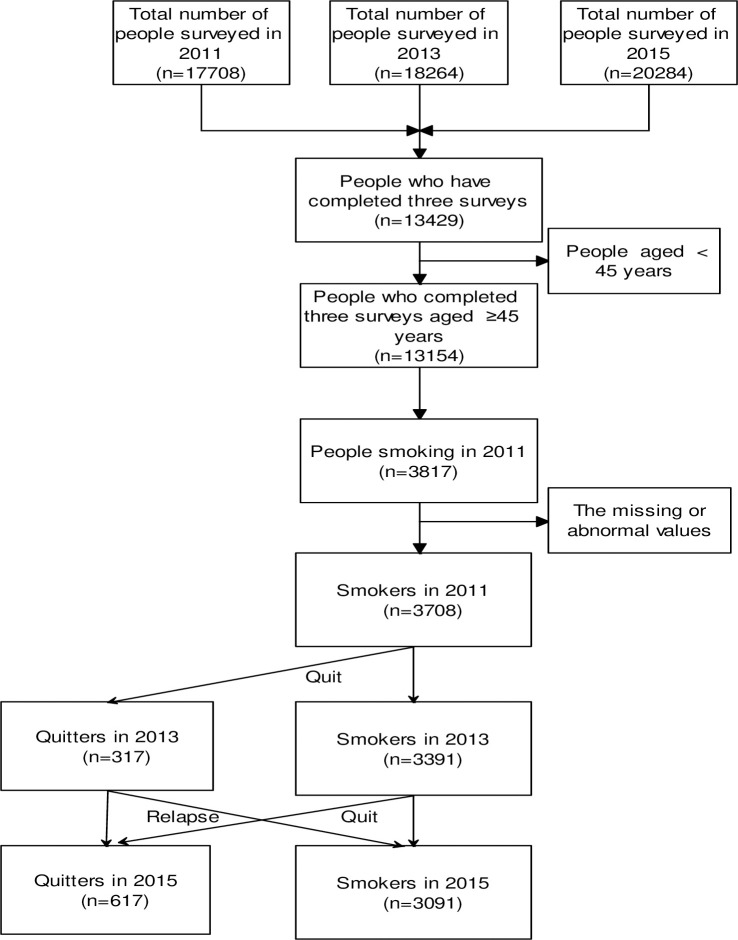
Flow diagram for the process of participant selection and follow-up.